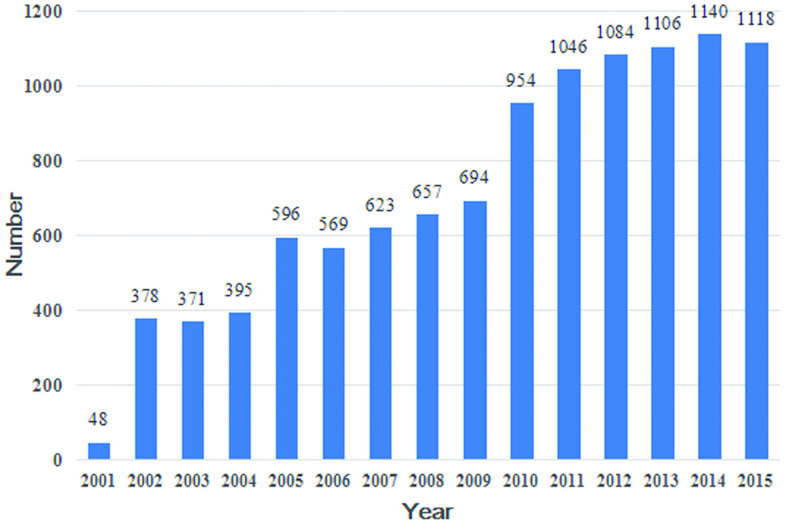
Number of renal biopsies per year.